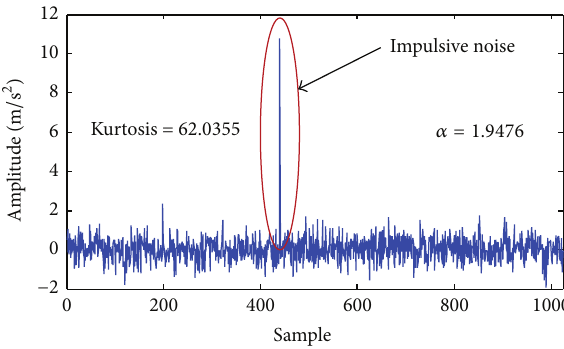
Figure 21: PDF of Gaussian signal added impulsive noise.